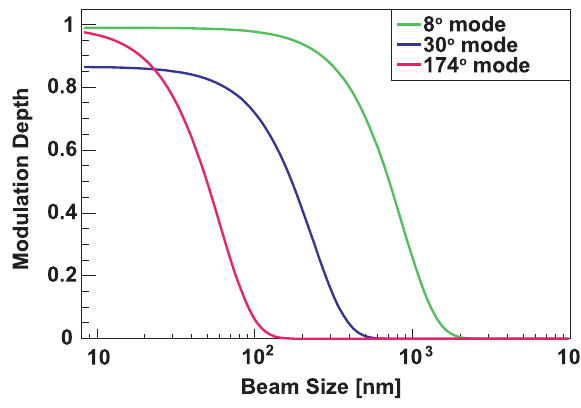
FIG. 3. IPBSM laser fringe modulation depth vs beam size, illustrating the dynamic ranges of the IPBSM modes